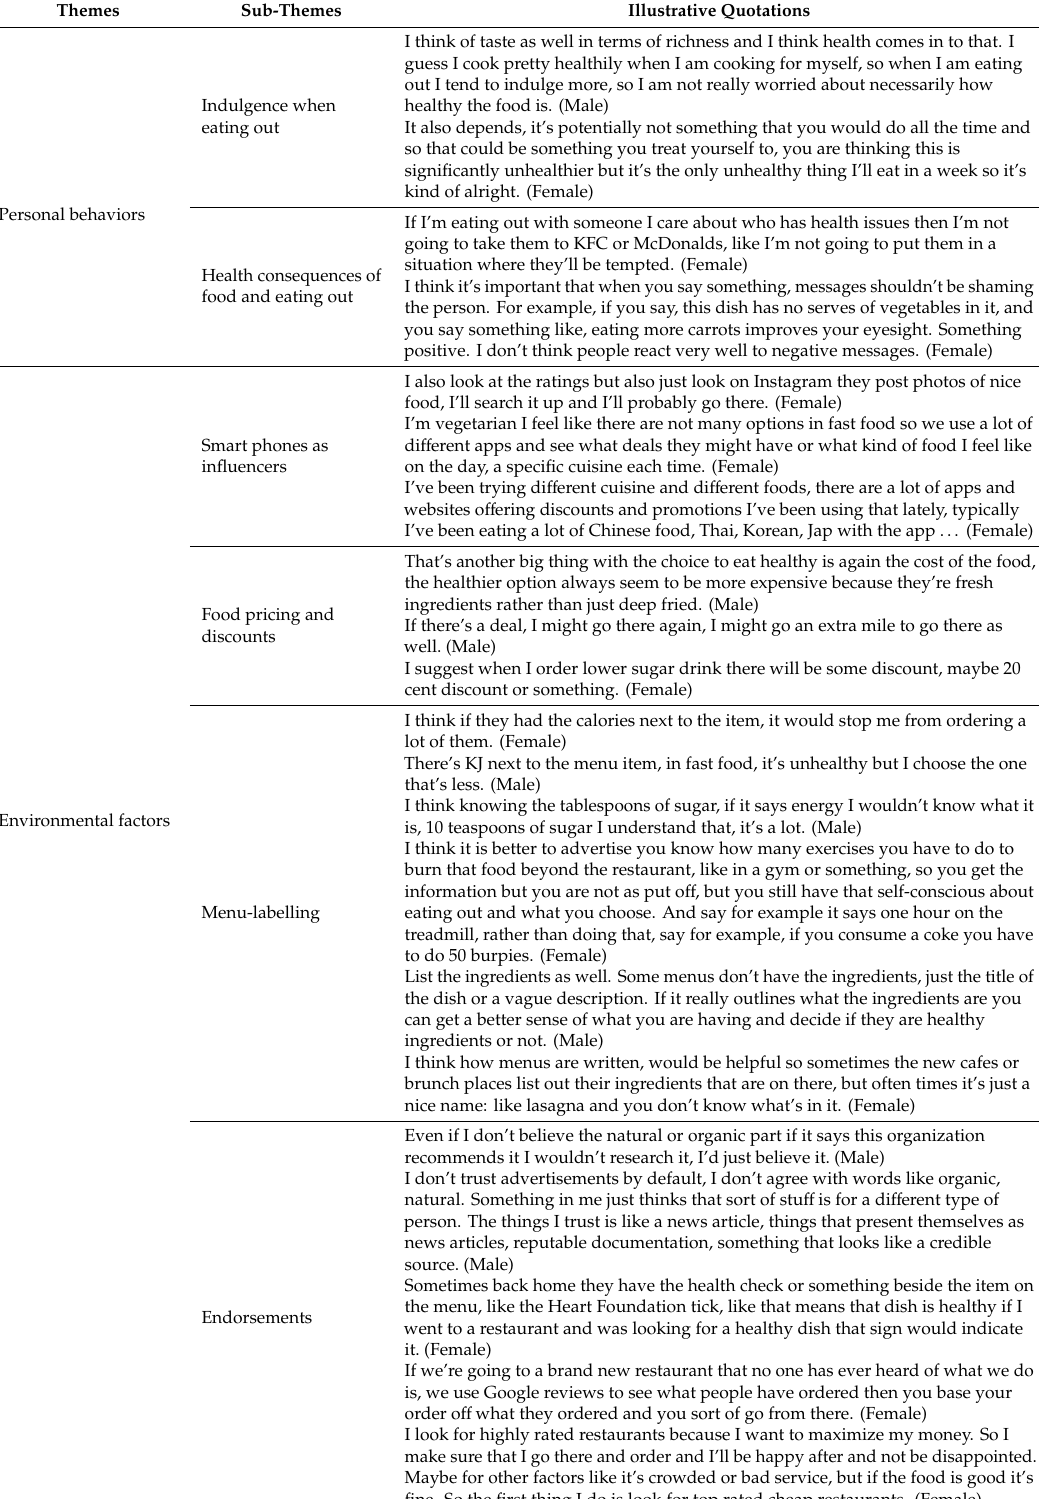
Table 2. Illustrative quotations of themes and sub-themes from the young adult